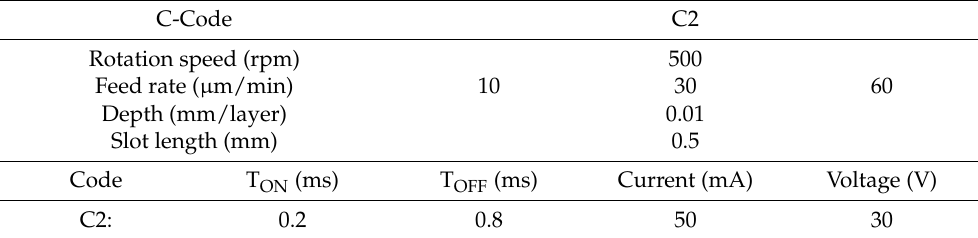
Table 4. Operation conditions for slot milling with deionized water.